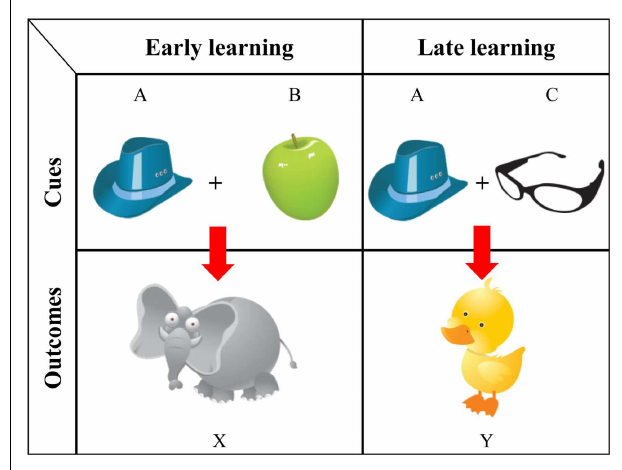
FIGURE 4 | Early learning from visually based cues (left) and inference-based knowledge (right).